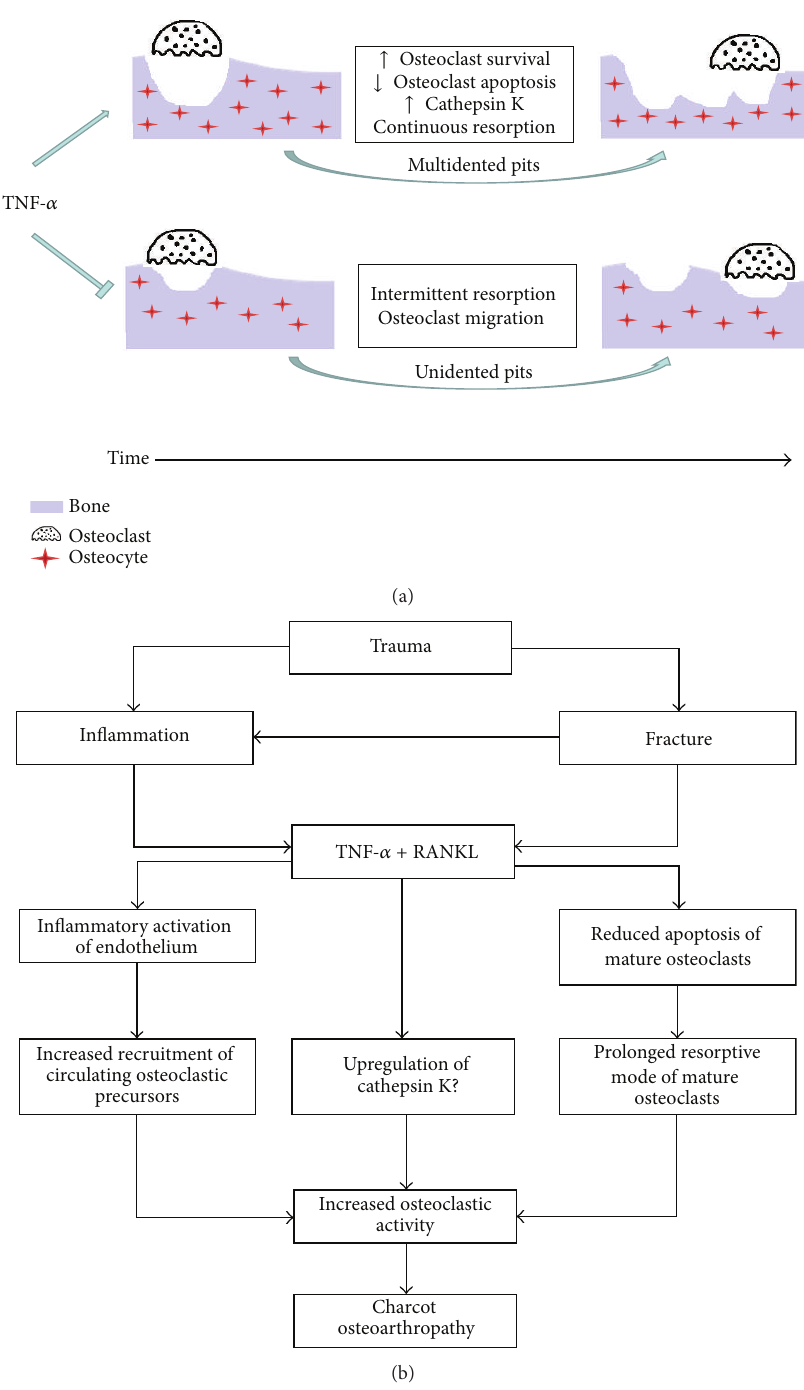
Figure 3: Model for osteoclast resorptive activity in Charcot osteoarthropathy in M-CSF + RANKL-treated cultures before and after the addition of anti-TNF- 𝛼 (a). In the presence of TNF- 𝛼 , continuous multidented pits (defined as lacunae or trenches) with increased area of resorption both on the surface and under the surface are seen more frequently compared with less frequently noted unidented pits (single resorption event). Resorption is prolonged and is not interrupted by migration episodes. After the inhibition of TNF- 𝛼 , the percentage of multidented pits is reduced with a corresponding increase in the percentage of unidented pits suggesting that the resorptive cycle is restored. Resorption alternates with migration and intermittent resorption events occur away from each other (unidented pits). The observed differences in the resorption before and after the addition of anti-TNF- 𝛼 suggest that TNF- 𝛼 (via cathepsin K upregulation) modulates the resorptive behaviour of osteoclasts generated from Charcot patients and these highly active osteoclasts are capable of extensive lacunar resorption with aberrant pit morphology and geometry due to reduced migration, increased survival, and reduced apoptosis. The proposed role of TNF- 𝛼 in the pathogenesis of pathological bone destruction in the acute Charcot foot